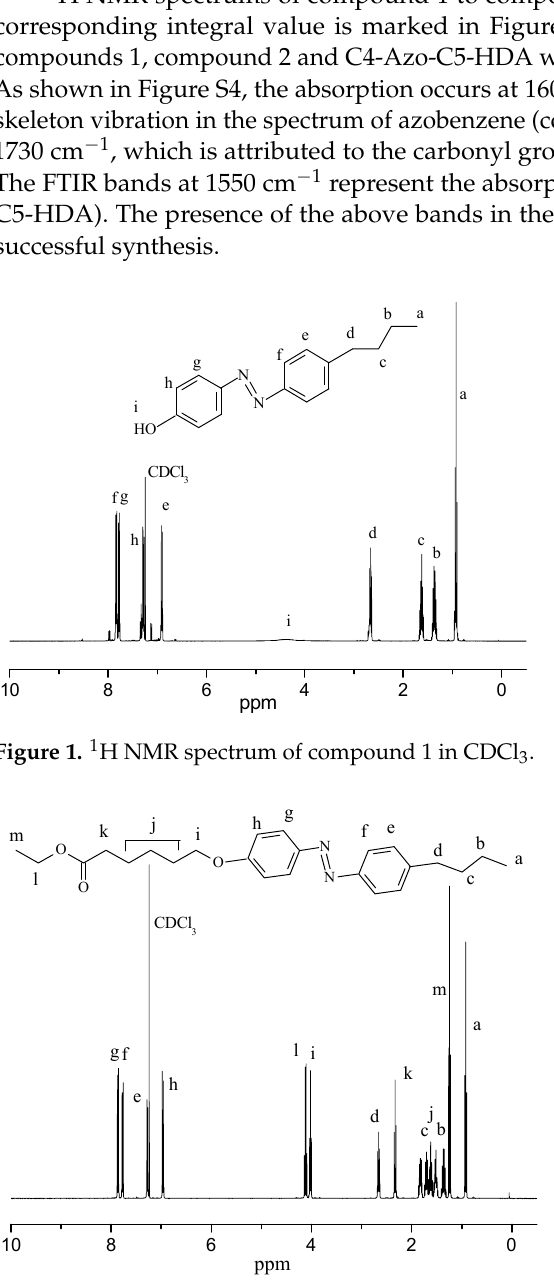
Figure 2. 1 H NMR spectrum of compound 2 in CDCl 3 .